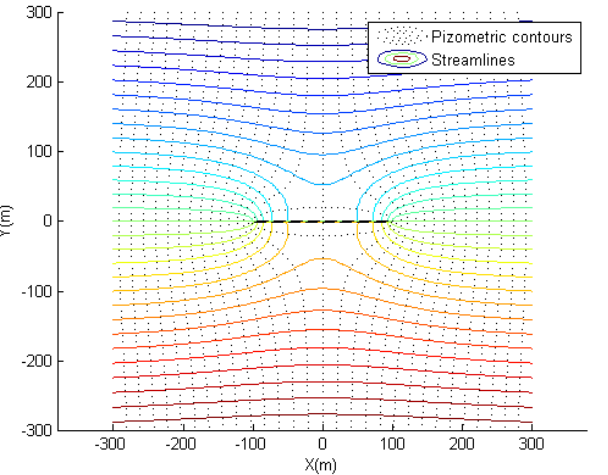
Figure 3. Numerical solution for single fracture obtained by the matrix method.